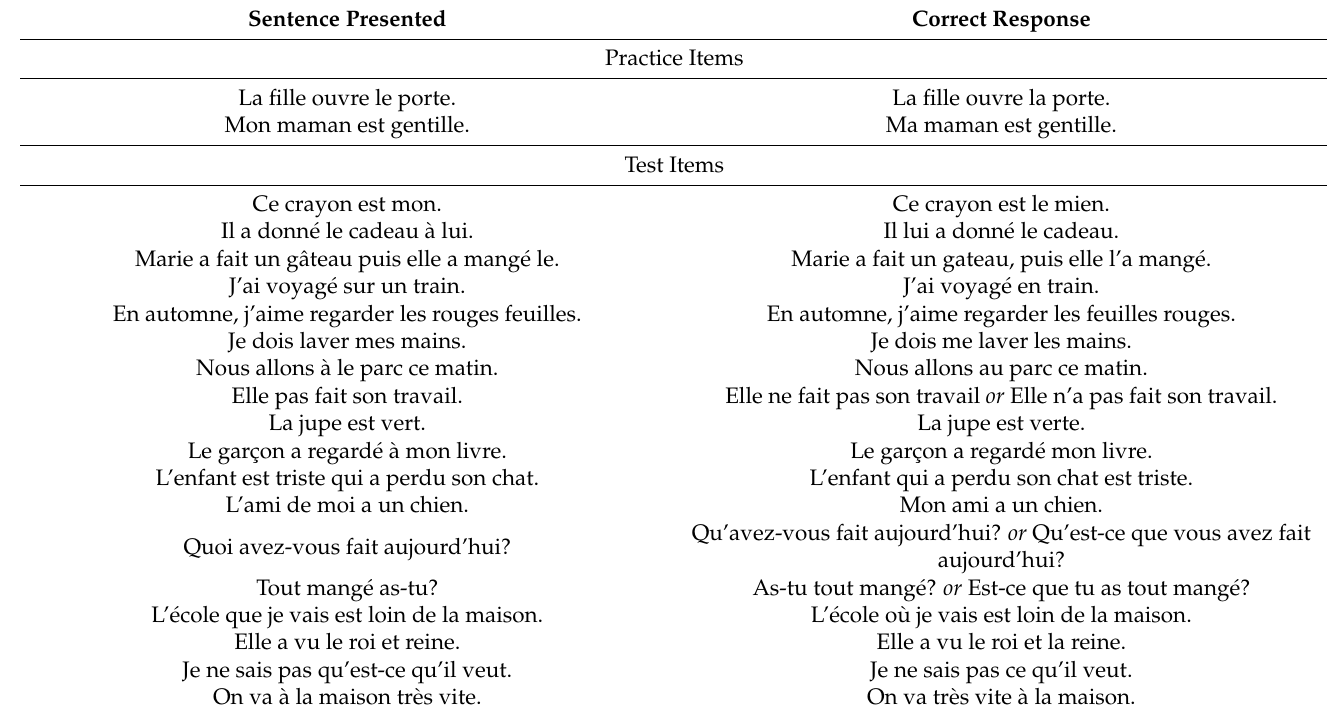
Table A2. Practice and Test Items on the French Syntactic Awareness